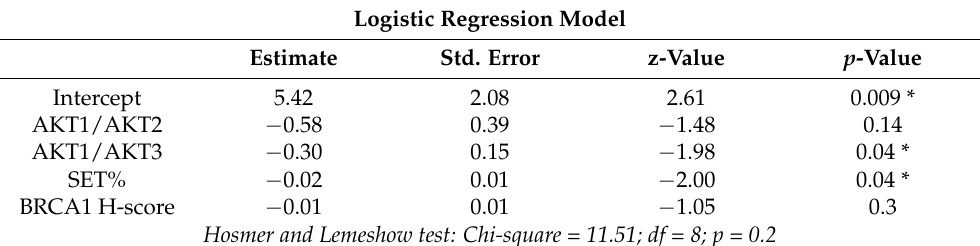
Figure A1. Kaplan–Meier survival curves for AKT isoform expression ratios. Overall survival for AKT1/AKT2 ( A ) and AKT1/AKT3 ( B ) ratios; progression-free survival (PFS) for AKT1/AKT2 ( C ) and AKT1/AKT3 ( D ) ratios. OS—overall survival; PFS—progression-free survival. Table A2. Prognostic factors for PFS identified by multivariate Cox regression analysis. Table A3. Estimates of the binomial logistic regression model for variables influencing HR status.